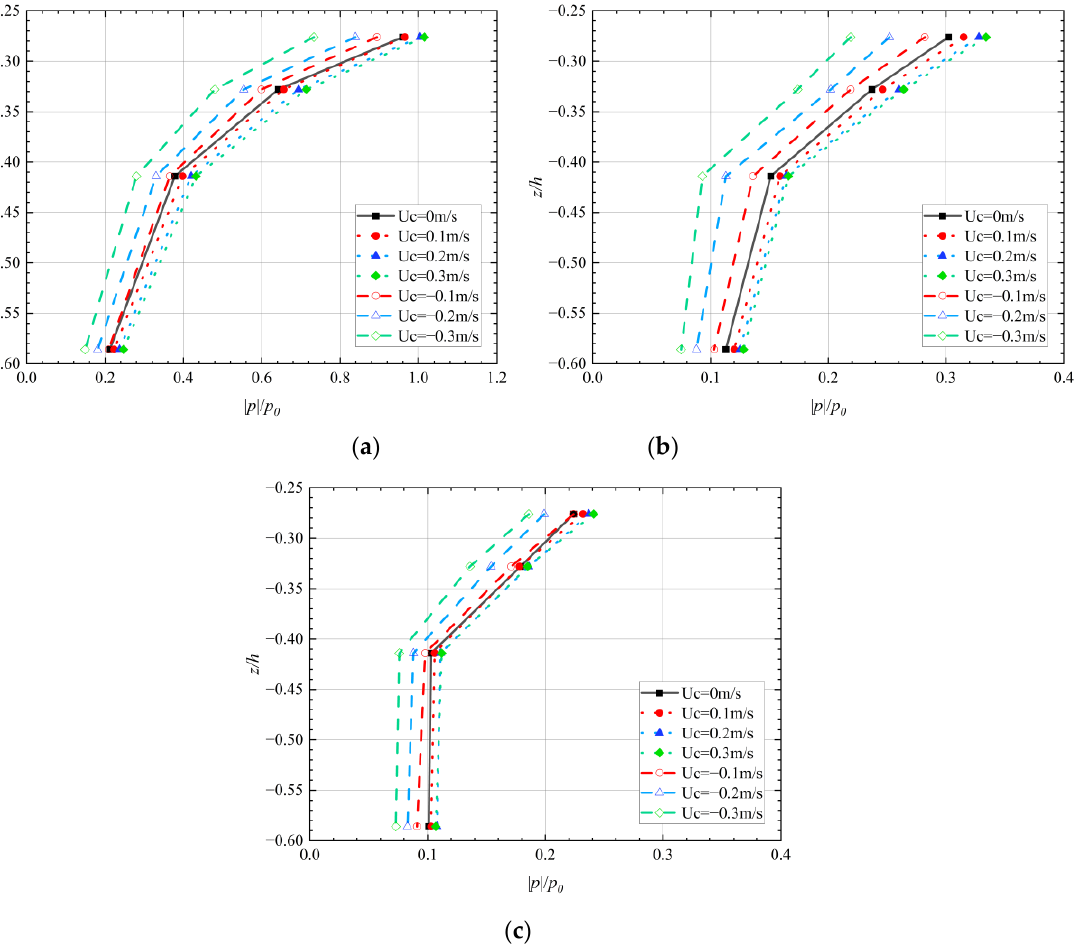
Figure 6. Variation of the dimensionless pore pressure amplitude beneath the pipeline under different backfill depth and current conditions. ( a ) e/D = 0; ( b ) e/D = 1; ( c ) e/D =